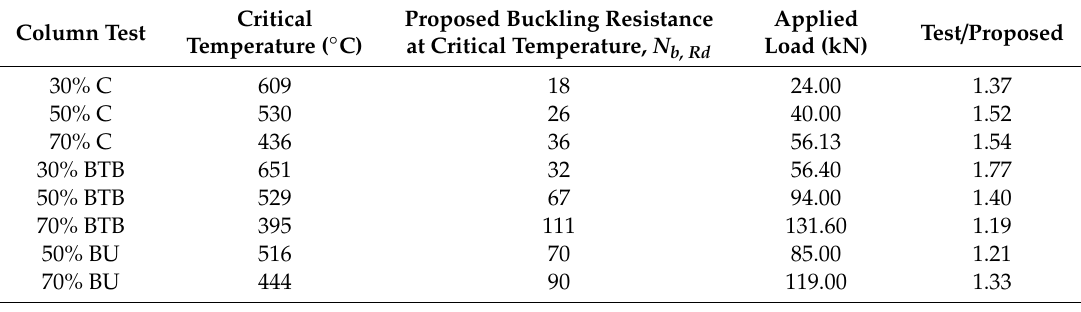
Table 3. The comparison of buckling resistance of CFS according to EC3-1-2 and experiment.